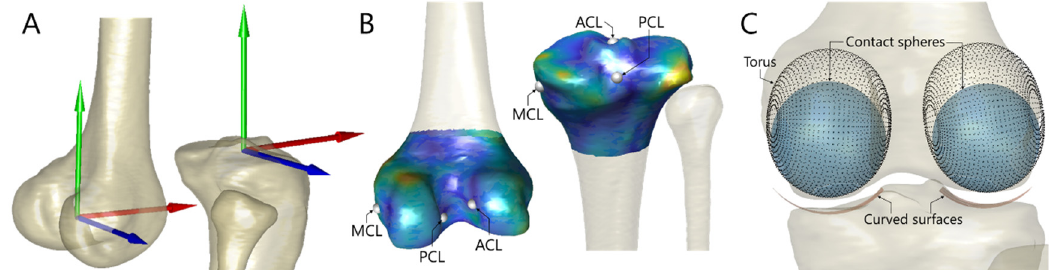
Figure 1. ( A ) Anatomical reference frames of the femur and tibia attached to the corresponding bone model were obtained using geometric features of the bone with an automated determination method. ( B ) The personalized endpoint positions of the knee ligaments were estimated by besting-fitting the statistical shape model (SSM, colored bone model) embedding known endpoint coordinates to the subject’s bone geometry (semitransparent model). The ligament endpoints from the deformed SSM were then projected onto the nearest face of the subject-specific model, determining the personalized ligament endpoint positions. ( C ) Congruent contact of the tibiofemoral joint was represented by the best-fitted bilateral torus (black dots) and the curved surfaces of tube geometry (red). Contact spheres (blue) nearest to the tibial plateau would also be identified given a specified tibiofemoral 3D pose.